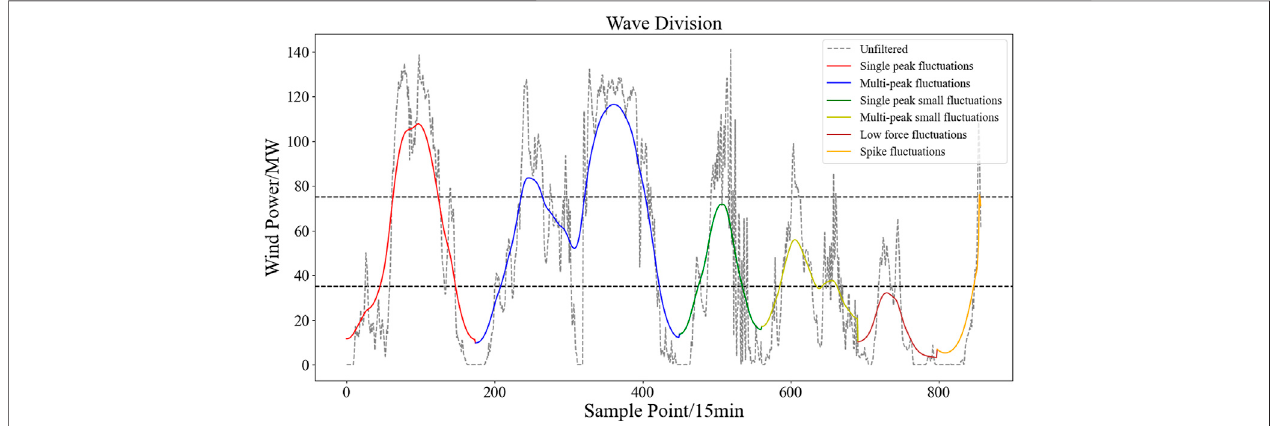
FIGURE 4 | Schematic diagram of volatility division. (1) Single-peaked large fl uctuations: The minimum value at both ends of the fl uctuation process is below the threshold z , the maximum value is greater than P ′ , the fl uctuation time span is less than W ′ , and the number of peaks is equal to 1.